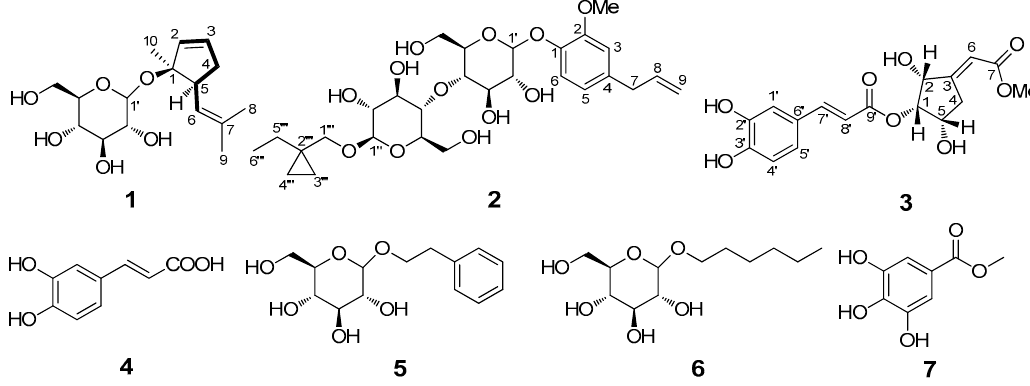
Figure 1 . Structures of compounds 1 – 7 and 1 H- 1 H COSY (bold) of 1 . Figure 1. Structures of compounds 1 – 7 and 1 H- 1 H COSY (bold) of 1